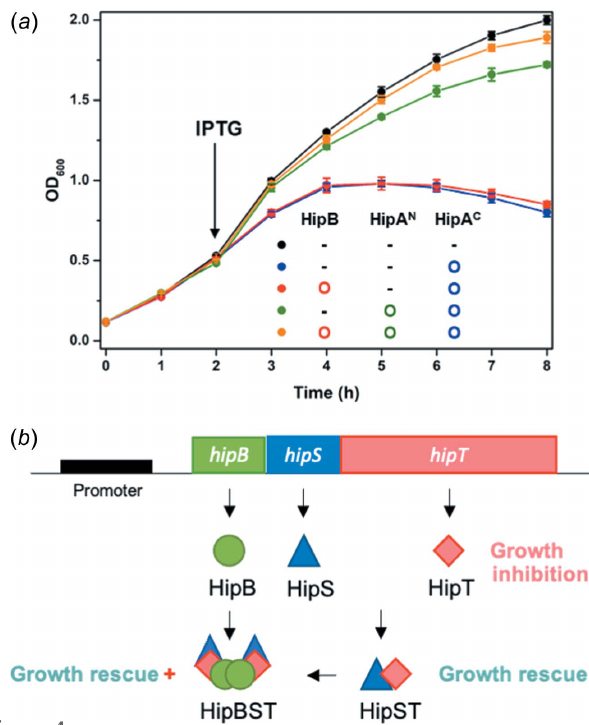
Figure 4 Three-component regulatory mechanism of the H. influenzae HipBA system. ( a ) Cell-growth analysis showing the effects of expression of different proteins. Each curve represents the growth of cells with a different combination of proteins, as presented within the graph. The data show the average values obtained by triplicate assays; the standard deviations are indicated by error bars. ( b ) Schematic overview of the presumptive regulatory mechanism according to the interactions between the components of the H. influenzae HipBA system.